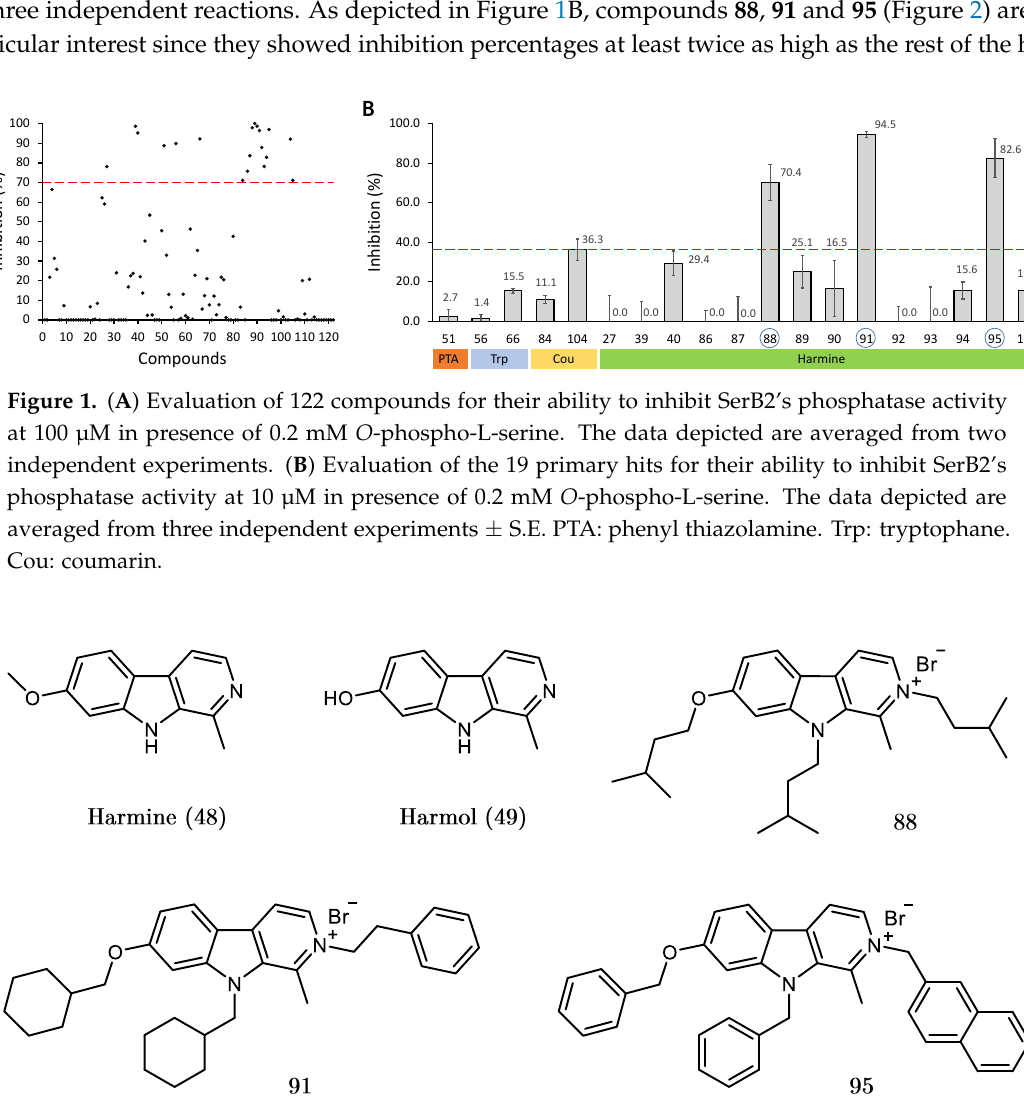
Figure 2. Structures of harmine, harmol and the three 2,7,9-trisubstituted harmine derivatives highlighted in this